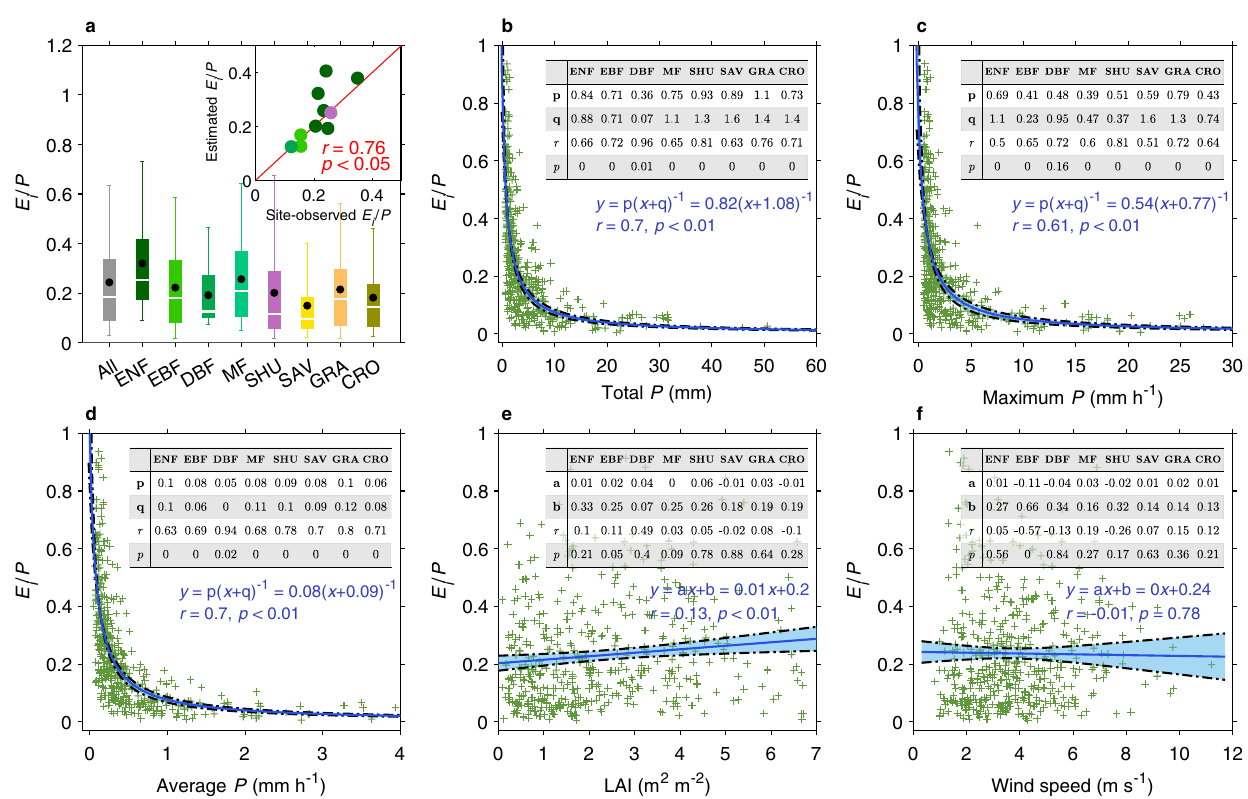
Fig. 3 | Event-level fraction of rainfall interception loss ( E i / P ) and its driving factors. a Median (white line), average (black dots), interquartile range (shading), and the 5th and 95th percentiles (whiskers) of E i / P across eight plant functional types (PFTs). The upper right scatterplot in a compares the estimated E i / P with observed E i / P at geographically close sites (Methods), with colors denoting the corresponding PFT de fi ned by the bars. The identity line is shown in red. b - f Scat- terplotsoftheevent-mean E i / P ratioagainstfourpotentialdrivingfactorsincluding total precipitation ( P ) ( b ), maximum hourly P ( c ), average hourly P ( d ), leaf area